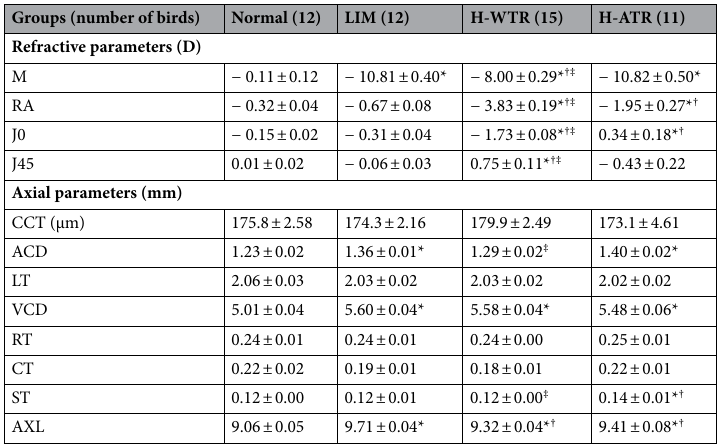
Table 1. Effects of the visual manipulations on refractive and axial parameters. Comparison of refractive and axial parameters in the treated eyes across the four groups were performed using One-way ANOVA with Bonferroni’s post-hoc tests. In addition, independent t-tests were performed to compare between the two sphero-cylindrical lens-wear groups (H-WTR and H-ATR). The level of significance is represented as follows: *p < 0.05, comparisons between the Normal group and the 3 lens treated groups (− 10 D, H-WTR and H-ATR); † p < 0.05, comparisons between the – 10 D group and the two sphero-cylindrical lenses treated groups (H-WTR and H-ATR); ‡ p < 0.05, comparisons between the two sphero-cylindrical lens-wear groups (H-WTR and H-ATR). M spherical equivalent, RA refractive astigmatism, J0 refractive J0, J45 refractive J45, CCT central corneal thickness, ACD anterior chamber depth, LT lens thickness, VCD vitreous chamber depth, RT retinal thickness, CT choroidal thickness, ST scleral thickness, AXL axial